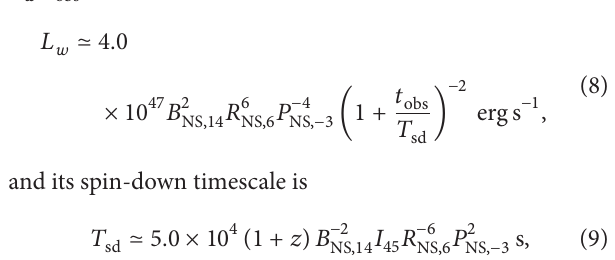
Figure 1: Evolution of the Lorentz factors of different regions when there is a density jump [47]. Two cases are calculated: one corresponds to the density jump ratio of 10 (a), and the other corresponds to the jump ratio 100 (b). The vertical dashed line marks the time of encountering the density jump. The green solid lines represent Γ 2 before encountering the density jump and Γ 4 during the encountering, both denoted by Γ Γ Γ = Γ Γ 4 . The blue solid lines and red solid lines represent 2 (or 3 , 2 3 ) and the thermal Lorentz factor of the baryons in Region 3 ( encountering, respectively. The horizontal dashed lines mark the values of corresponding Lorentz factors (which remain constant during the reverse shock crossing time) given by [57]. Note that Γ 4 (see the green solid lines) during the encounter is almost constant (slowly increasing due to adiabatic expansion), which is shown as a “plateau” that is significantly shorter than that of Γ 2 . The shortness of the “plateau” of Γ 4 is due to the different transformation formula between the burst frame time and the apparent time in the observer